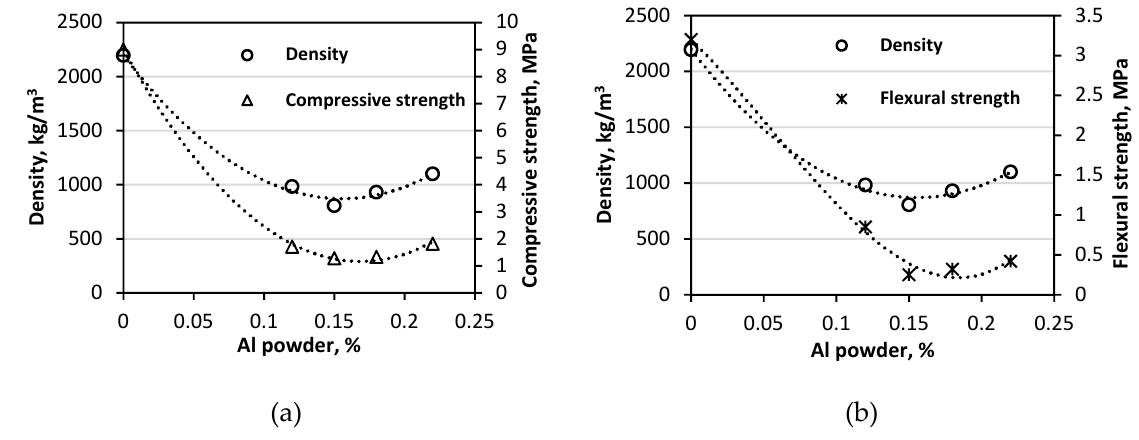
Figure 5. Density values and ( a ) compressive strength, ( b ) flexural strength of geopolymer pastes after 28 days of hardening, in function of different % Al powder additions at S/L: 3.5 g/mL, 8 M KOH and 70 °C curing temperature.